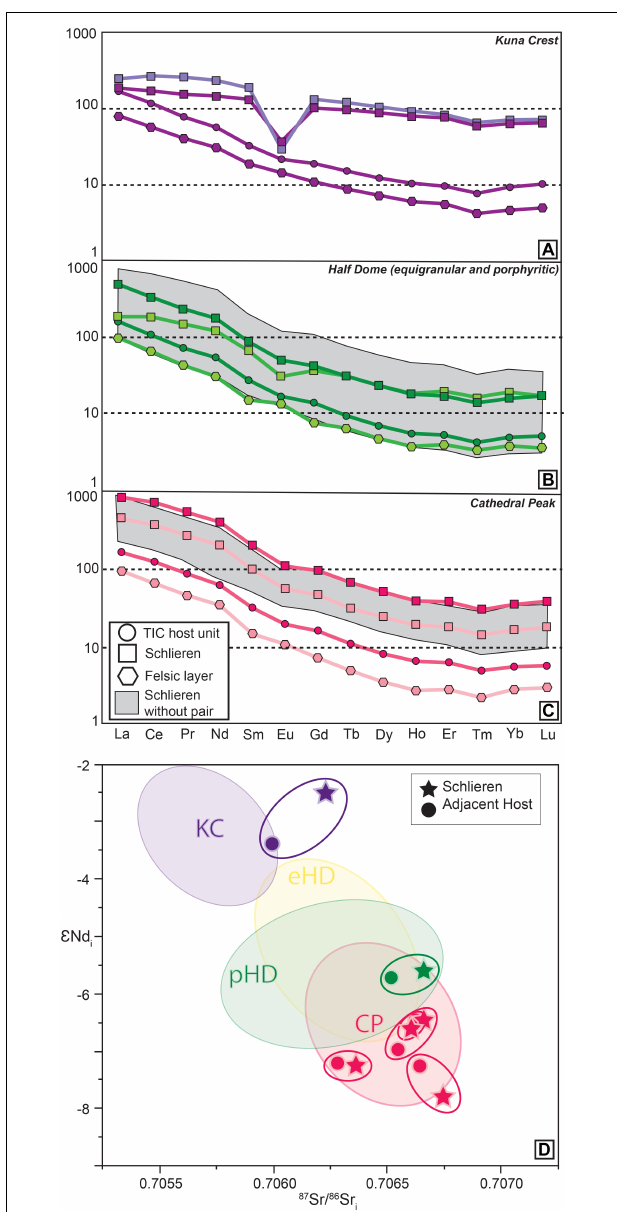
FIGURE 11 | (A–C) Rare Earth Element patterns in TIC host, schlieren and felsic components. Plots are divided up by major unit. (A) Kuna Crest granodiorite [sample data from Memeti (2009)]. (B) Half Dome granodiorite units. eHD and pHD have been combined to maximize data coverage. (C) Cathedral Peak granodiorite. Matching colors indicate that the samples were collected from the same outcrop, at adjacent layers. Normalized after Sun and McDonough (1989). (D) Whole rock isotopes 87 Sr/ 86 Sr i v. ε Nd i . TIC samples are color-coded by unit. They define a broad isotopic range. Schlieren-host pairs collected at the same outcrop are circled. Fields defined by host rock samples as shown in Memeti et al. (2014). Standard errors are